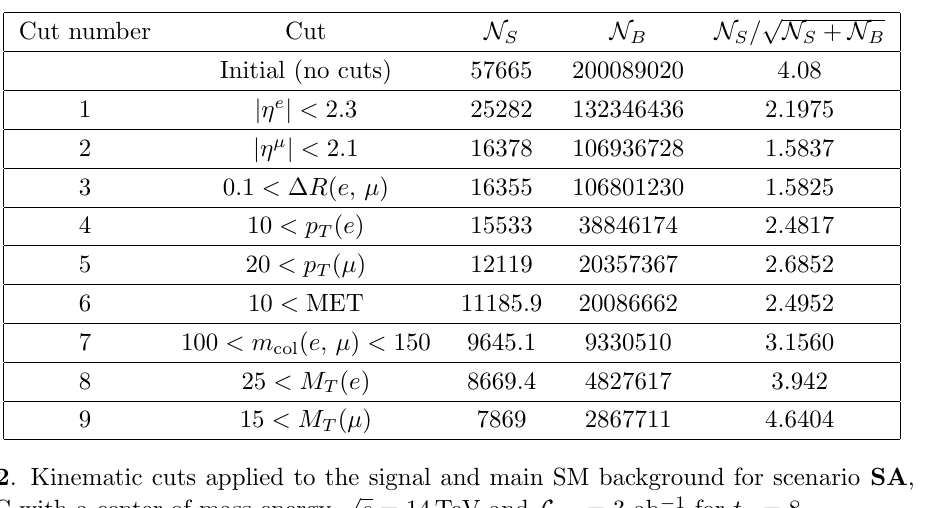
= 3 ab (cid:0) 1 for t (cid:12) = 8. L int